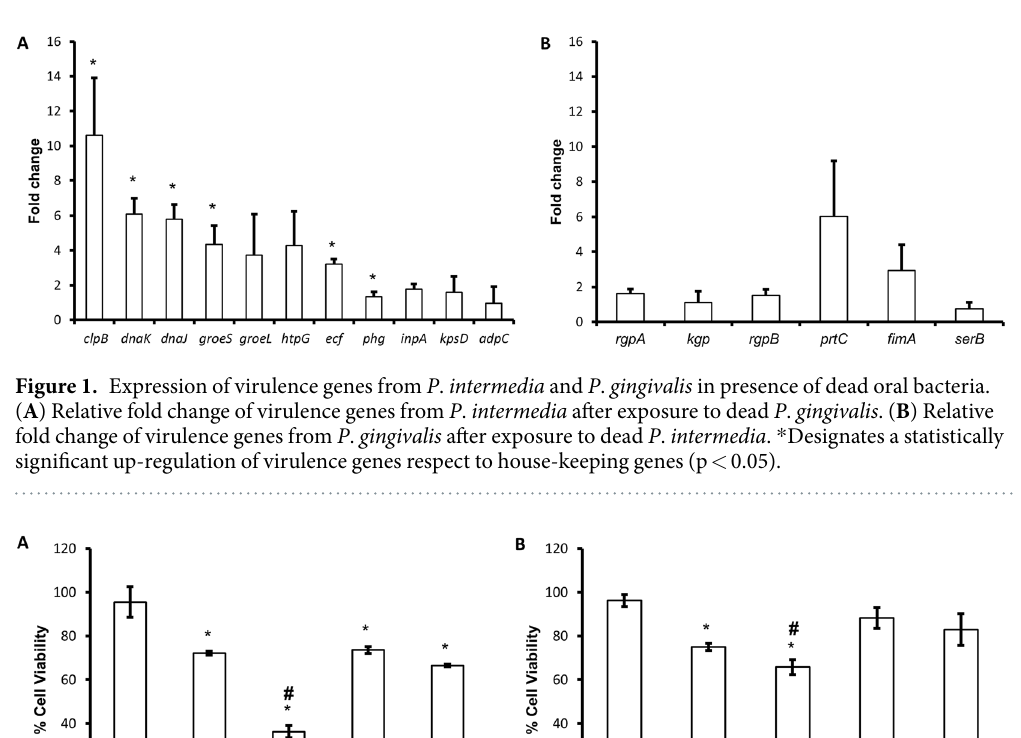
Table 3. Vitality qPCR (Log (MO/mL) of the different species (mean ± standard deviation, n = 3) in the 14 species community in presence of living and dead bacteria in BHI-2 after 24 hours incubation. BHI-2 condition refers to a 14 species community without the addition of dead bacteria. * Designates a statistically significant increase of the bacterial concentration with respect to BHI (p < 0.05). # Designates a statistically significant decrease of the bacterial concentration in respect to BHI (p < 0.05).